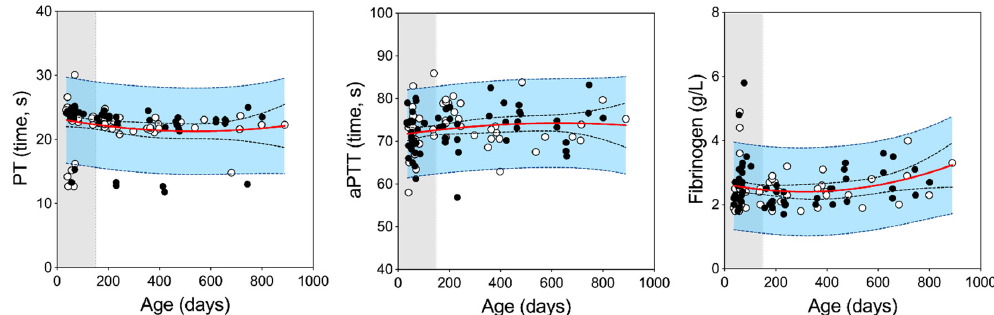
Figure 1. Prothrombin time, activated partial thromboplastin time and fibrinogen values for juvenile and adult strain 13/N guinea pigs. Sodium citrate whole blood samples collected from juvenile (shaded; age ≤ 150 days) and adult (unshaded; age 151–900 days) were processed and analyzed for PT, aPTT, and fibrinogen. Open circles, female; closed circles, male; red line, mean; black dotted lines, confidence intervals of the mean; dotted blue lines and blue shading, 95% predictive values.